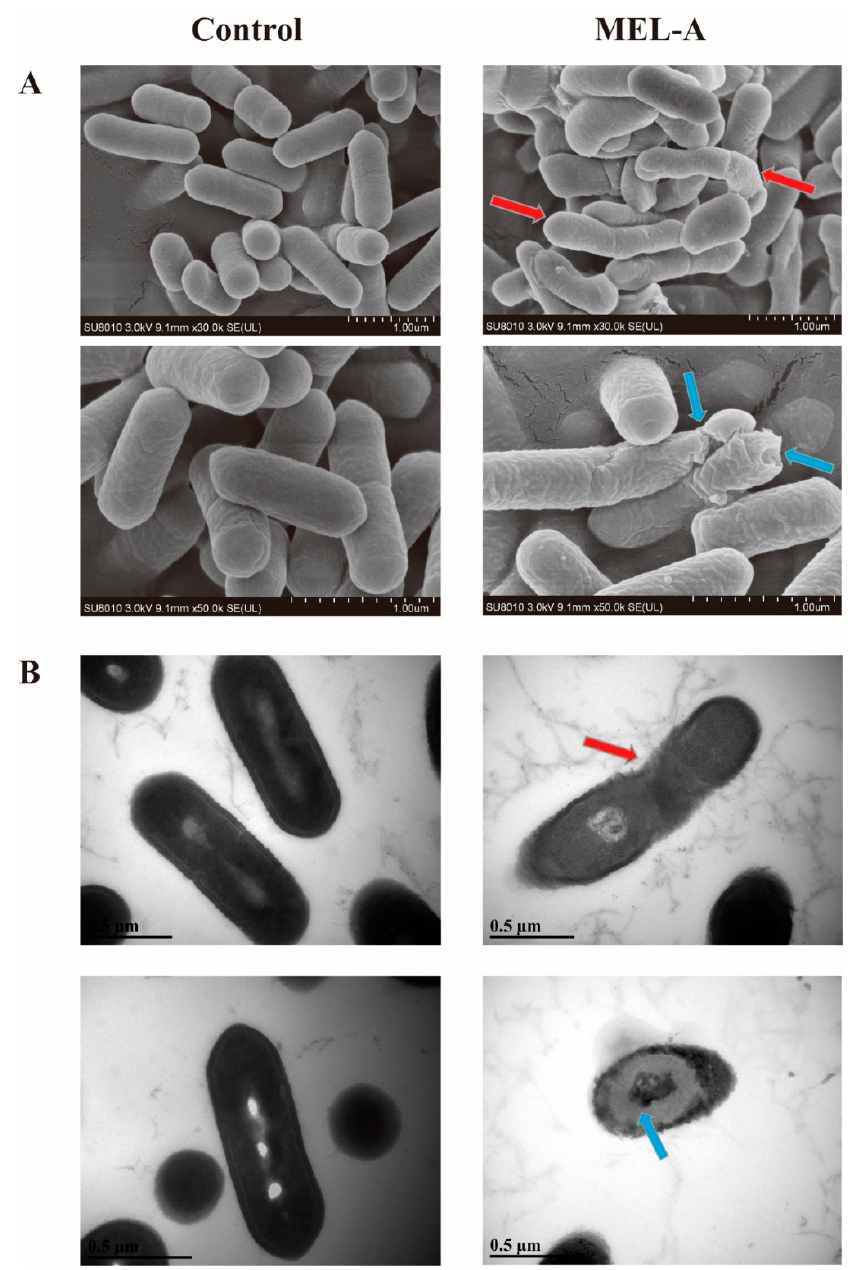
Figure 4. SEM ( A ) and TEM ( B ) micrographs of L. monocytogenes treated with MEL-A at the minimum inhibitory concentration (MIC) and control cells without treatment.